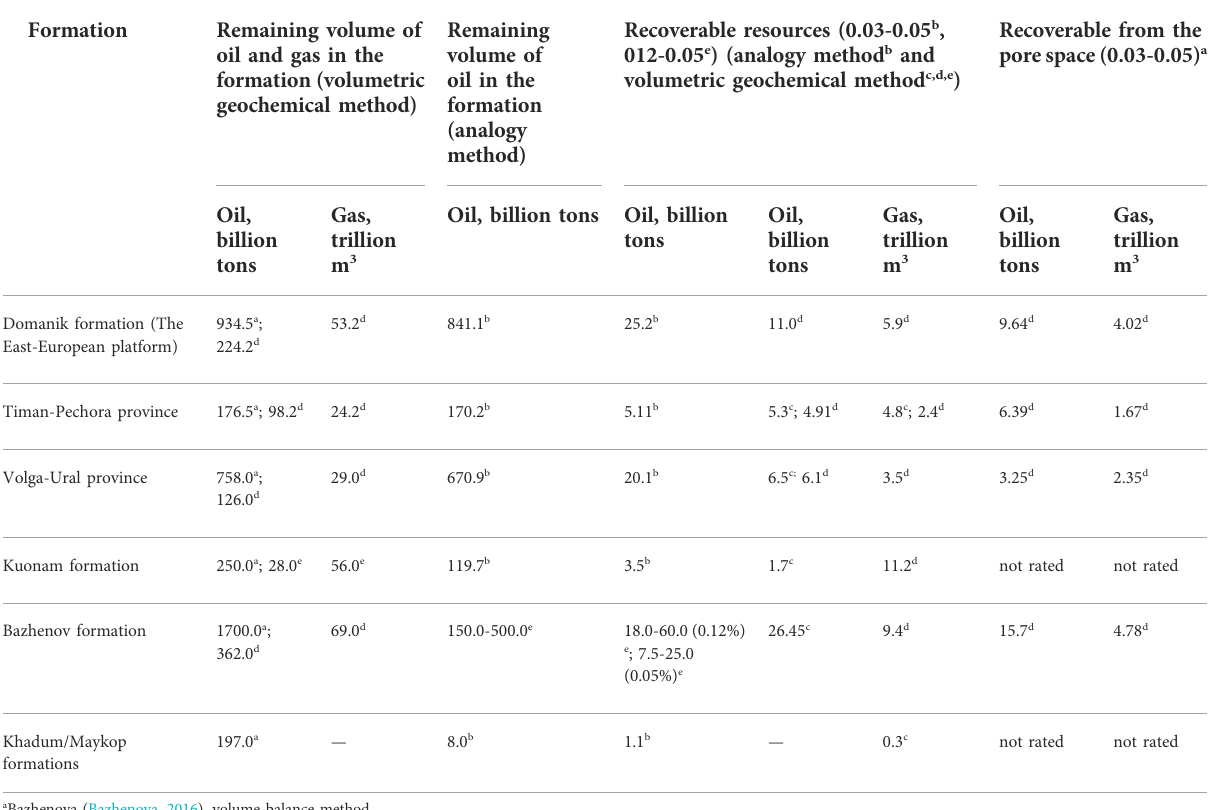
TABLE 11 Comparison of estimates of resources of scattered hydrocarbons and those concentrated in places of their